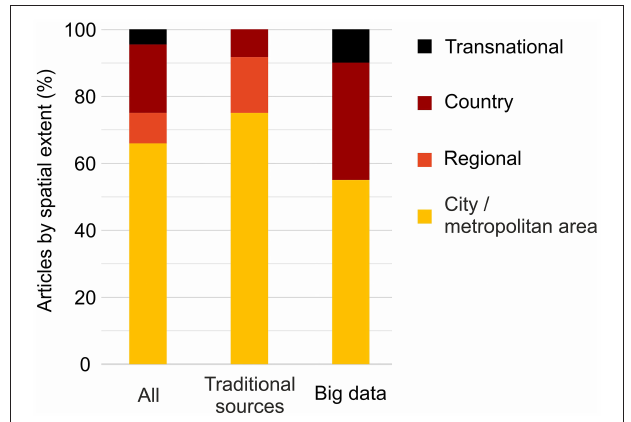
FIGURE 7 | Distribution of articles by the spatial extent of the case study in all activity space segregation studies ( n = 44), and separately in studies using traditional data sources ( n = 24) and big data sources ( n = 20).